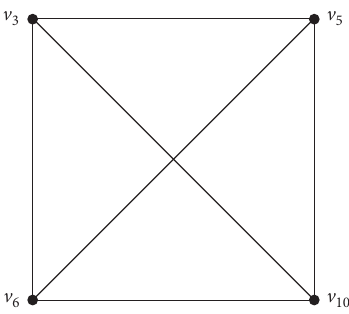
Figure 3: Graph G I ( Λ ), where Λ = < 3, 5, > and I ={8, 9, 11,